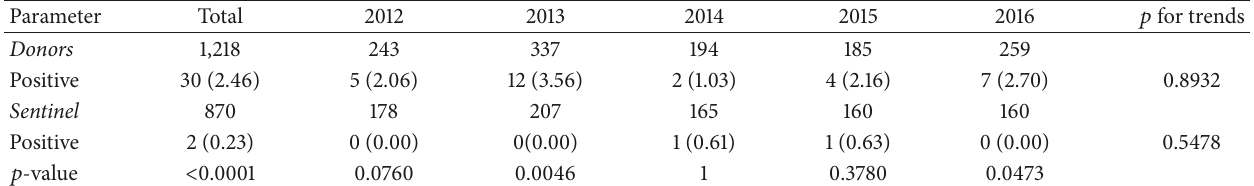
Table 4: Year-on-year prevalence of new Syphilis (15–24 years) infection among blood donors and pregnant women in the Ho municipality.